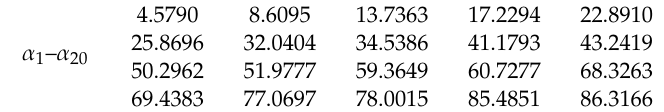
Table 4. Values to bipolar 20 switching-angle case (unit: degree) when V ac 1 = 0.8, V ac 2 = 0.4 (normalized), k = 39.